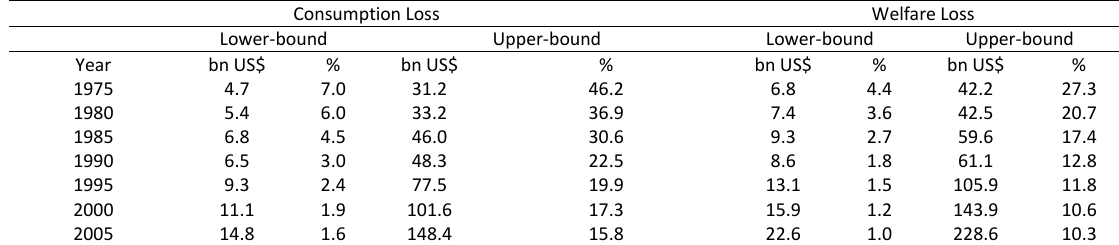
Table 5: Estimated absolute consumption and welfare losses due to air pollution in China (Matus et al., 2011)